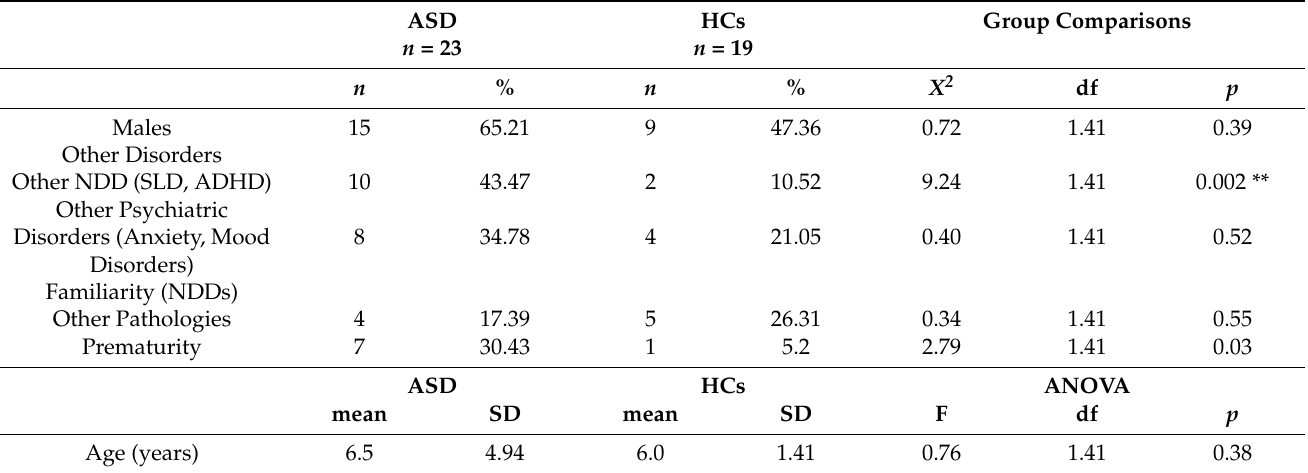
Table 3. Demographic and clinical characteristics of children.